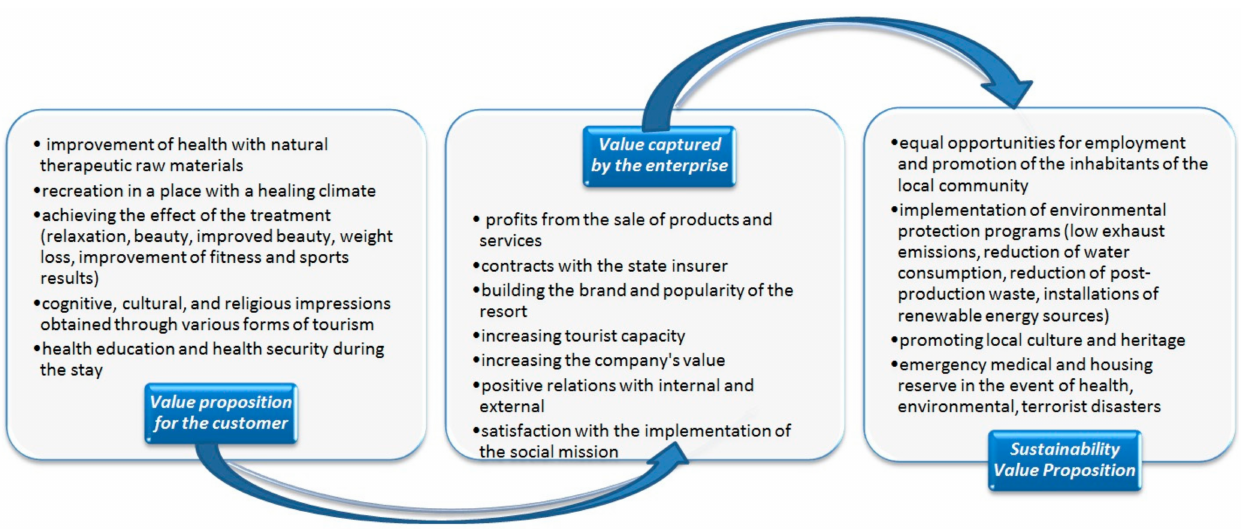
Figure 3. A holistic view of sustainable value integrating economic, environmental, and social. Source: Own